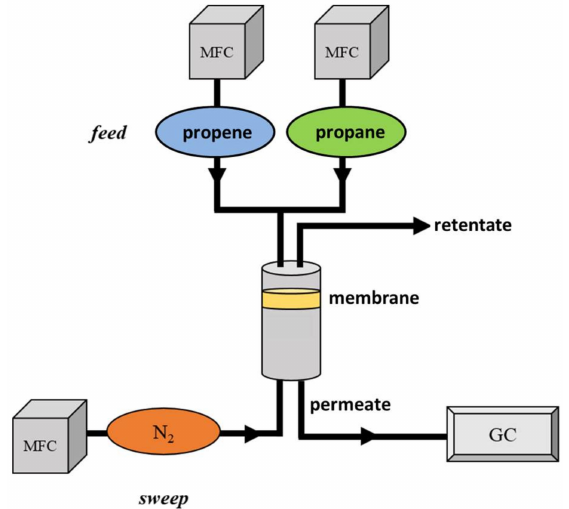
Figure 10. Schematic view of the experimental setup according to Wicke Kallenbach used for permeation measurements with mixed matrix membranes (MMMs) and binary propane/propene